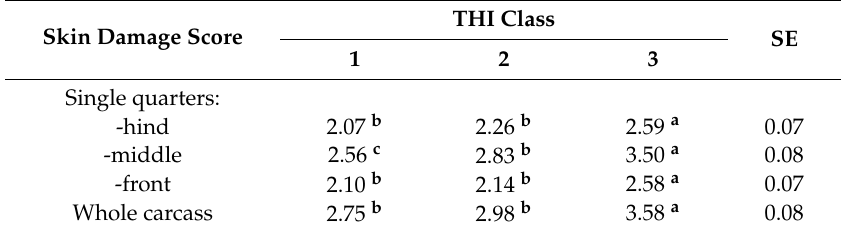
Table 5. Effect of the Temperature Humidity Index (THI) class on the skin damage score (1) of single quarters and whole carcass of Italian heavy pigs (least squares